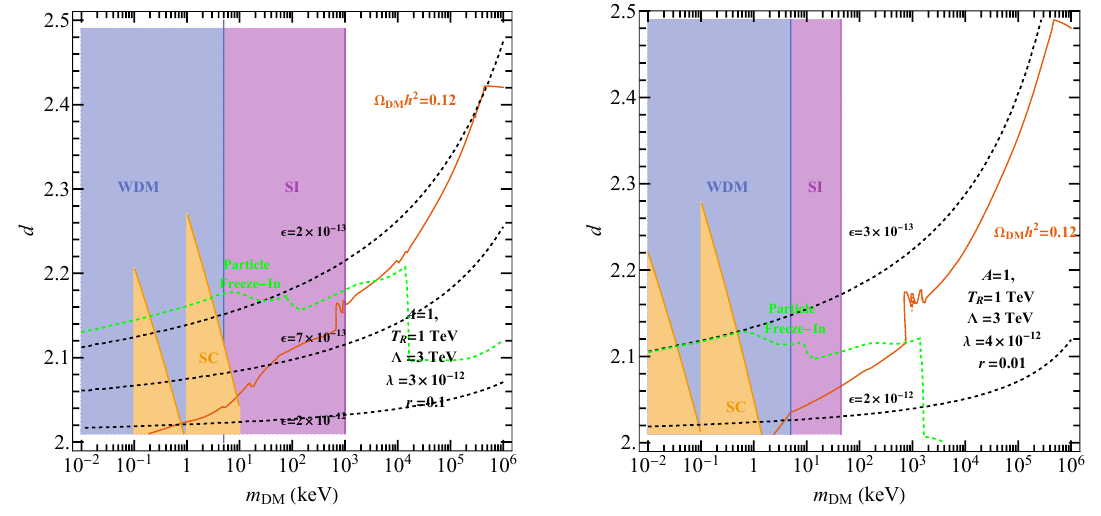
Figure 3 . The dark matter mass and the CFT operator scaling dimension which reproduces the dark matter relic density (orange-red solid line) with r = 0 . 1 (left) and r = 0 . 01 (right). For comparison, the green dashed line shows an estimate for the expected parameters which reproduces the observed relic density for the “usual” freeze-in with kinetic mixing parameter given by eq. (2.12) and the same relation between the dark photon mass and dark matter mass [14]. The blue shaded region corresponds to the region of parameter space excluded by the warm dark matter bound. The yellow shaded region corresponds to the stellar cooling bound. The purple shaded region is excluded by the DM self-interaction bound coming from the observation of bullet-cluster. The dashed curves show contours of constant kinetic-mixing parameter, (cid:15) , with g s = 1